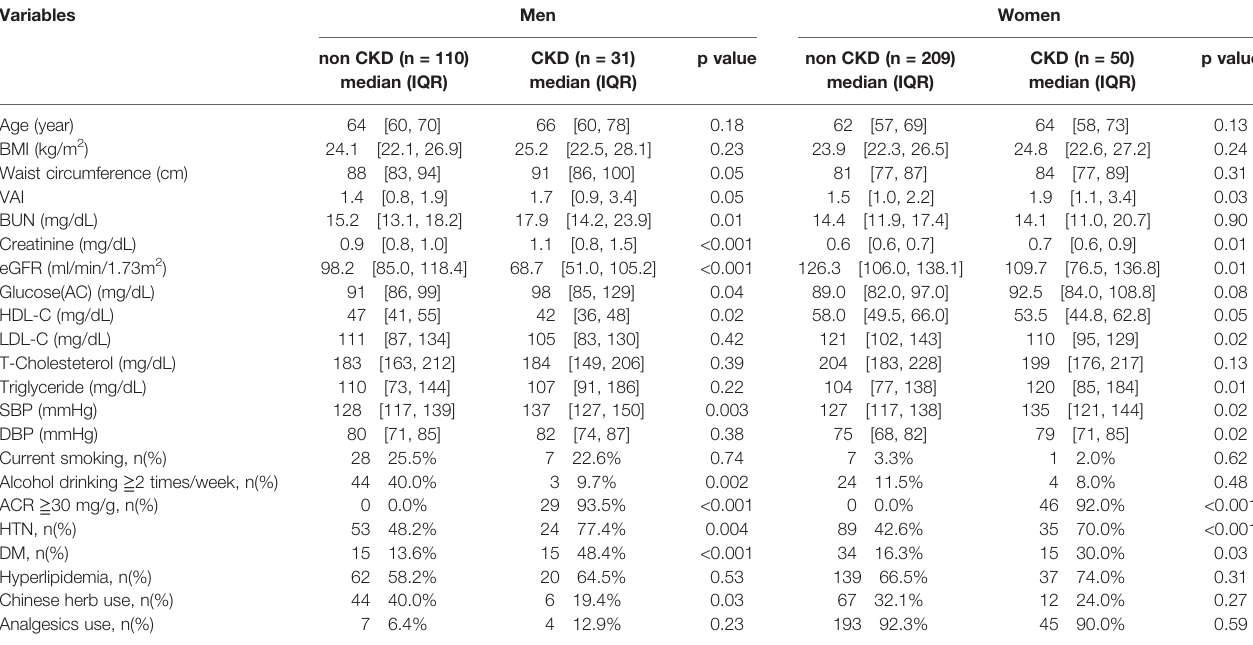
TABLE 2 | General characteristics according to gender in the study population with CKD and non-CKD. Variables Men